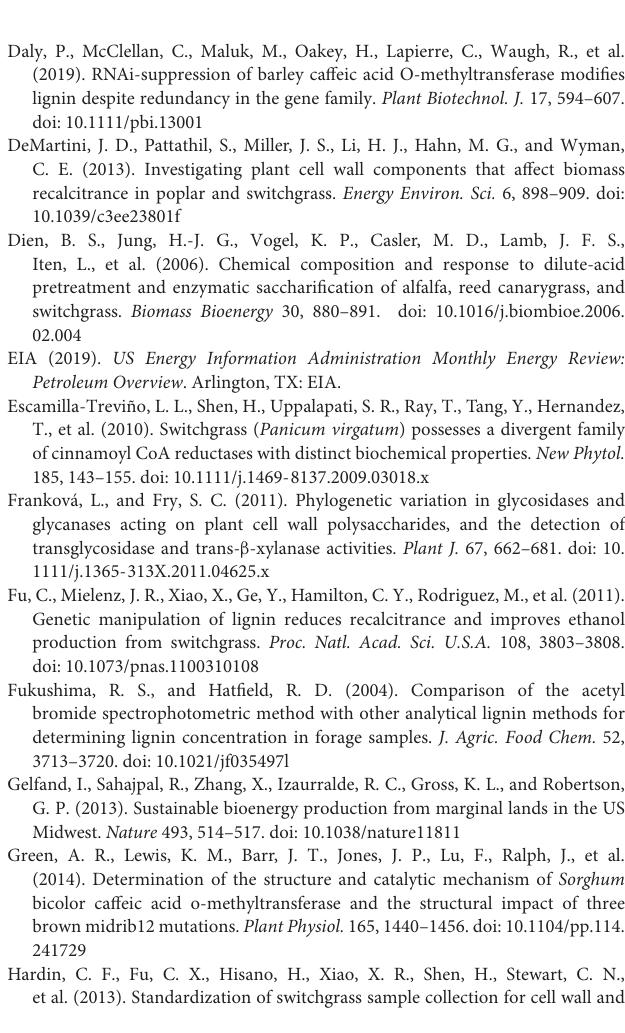
Supplementary Figure 1 | Dependence of enzymatic deconstruction results on NaOH concentrations. Supplementary Figure 2 | Caffeic acid 3-O-methyltransferase (COMT) phylogeny. Supplementary Figure 3 | Principle component analysis of phenylpropanoid biosynthesis gene expression data. Supplementary Figure 4 | Heatmaps of Gini correlations between phenylpropanoid biosynthesis gene expression and cell wall properties for highest performing models. Supplementary Table 1 | qRT-PCR Primers. Supplementary Table 2 | Significant correlations among cell wall components. Supplementary Table 3 | Cell wall and gene expression data. Supplementary Table 4 | Gini correlation results between phenylpropanoid gene expression and cell wall traits (N vs. N), or a change in cell wall traits (N vs. N +1 and N vs. N +2). Supplementary Table 5 | Gini correlations between phenylpropanoid gene expression and cell wall parameters for various models and data